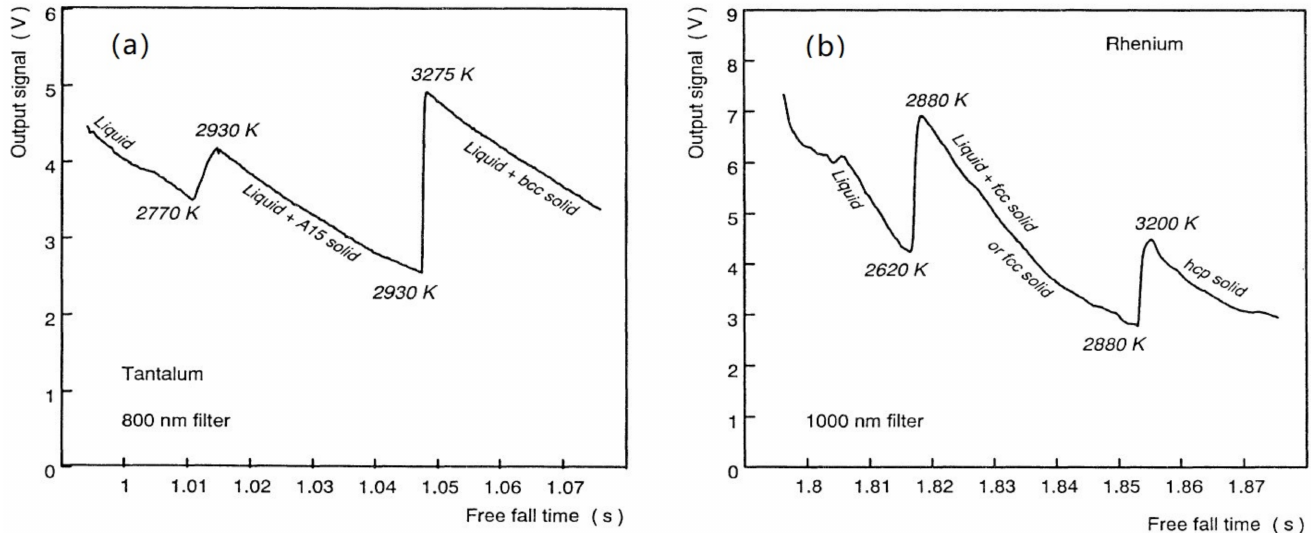
Figure 11. ( a ) Brightness trace during solidification of a tantalum droplet during its free fall. The two successive re- calescence peaks show evidence of a double transformation phenomenon. ( b ): Brightness trace during solidification of a rhenium droplet during its free fall. The two successive recalescence peaks still show evidence of a double transformation phenomenon. Reprinted with permission from [80]. Copyright 1993